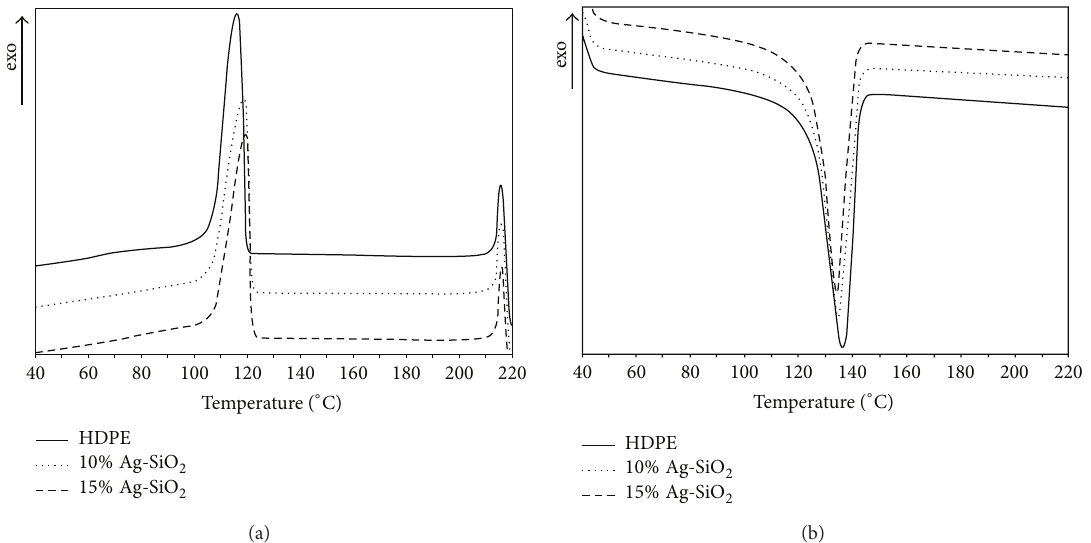
Figure 6: DSC curves of HDPE and nanosilica containing immobilized nanosilver filled HDPE composites: second heating (a) and cooling run (b).